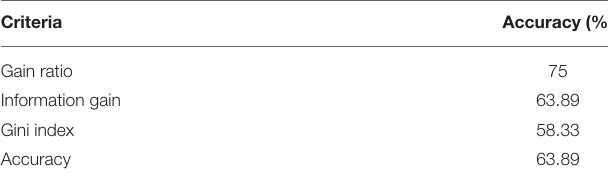
TABLE 7 | Accuracy comparison of constructed DT models by different